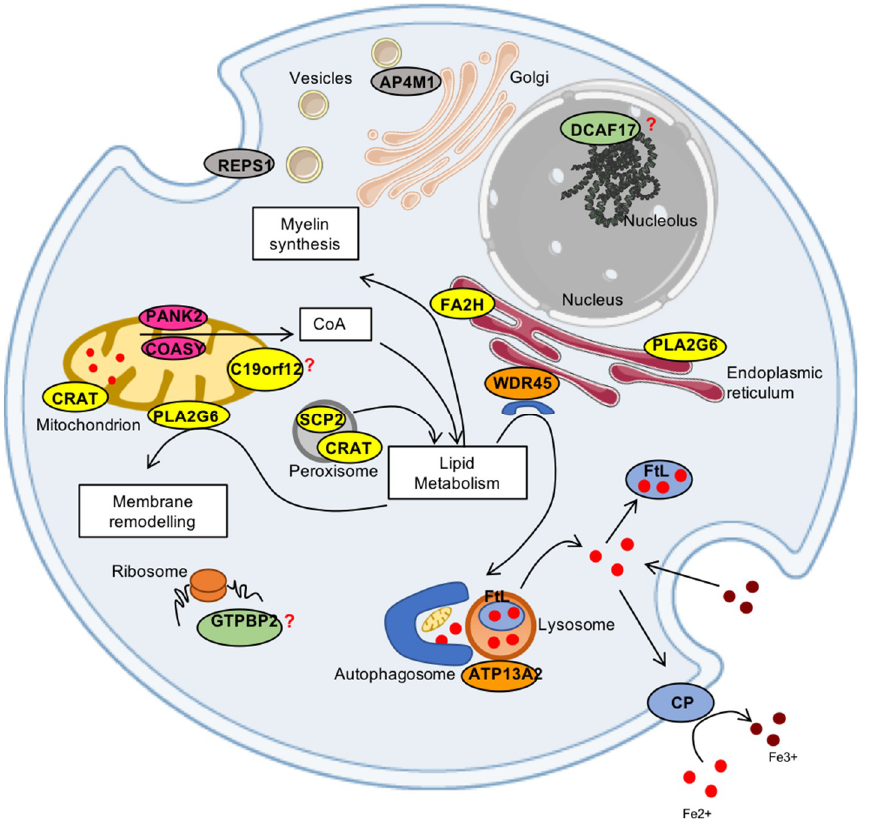
Figure 1. Scheme of the proteins associated to NBIA disorders and their cellular localization. The iron proteins (CP and FtL) are represented in light blue; in pink are the proteins (PANK2 and COASY) are involved in CoA synthesis; in yellow are the proteins related to lipid metabolism (PLA2G6, FA2H, SCP2, CRAT, C19orf12); in orange are the proteins (WDR45, ATP13A2) involved in autophagy; in grey are the proteins (RESP1 and AP4M1) associated to vesicle trafficking; and the proteins (DCAF17 and GTPBP2) in green still have unknown functions.